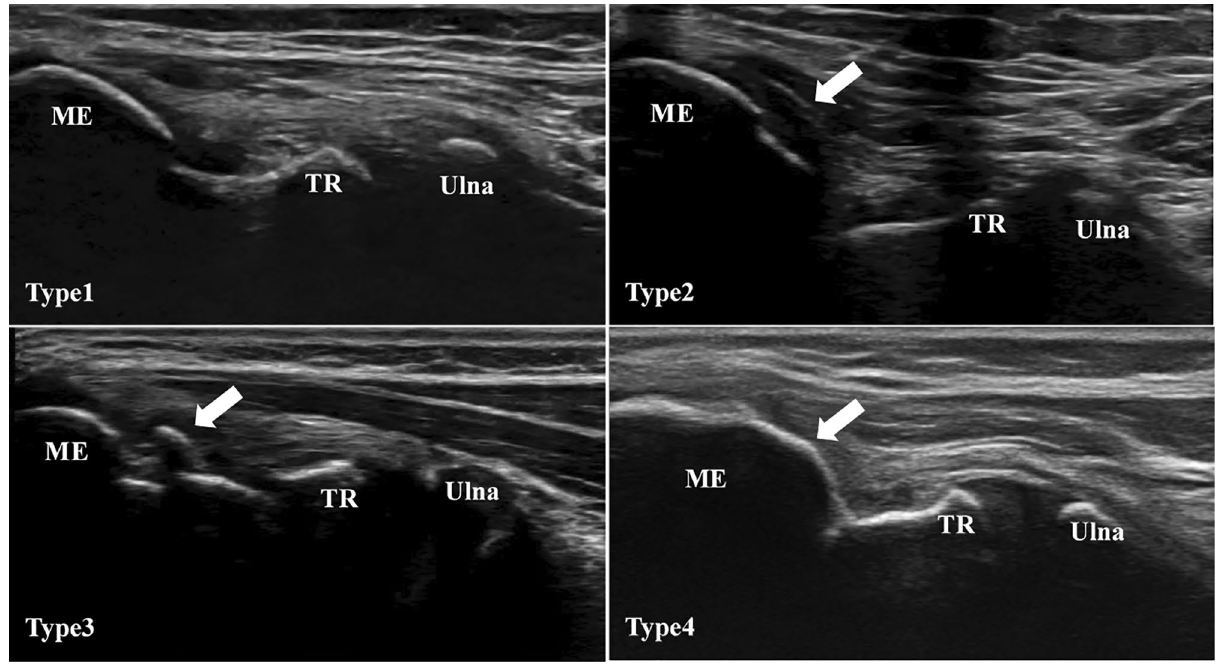
Figure 2. Longitudinal ultrasonography images of the medial elbow joint. Type 1: normal (upper left); Type 2: arrow indicates a blurred image of the MCL at the attachment to the medial epicondyle (upper right); Type 3: arrow indicates segmentation of the medial epicondyle at the attachment of the MCL (lower left); Type 4: arrow indicates protrusion of the medial epicondyle at the attachment of the MCL (lower right). MCL, medial collateral ligament; ME, medial epicondyle; TR, trochlea U;